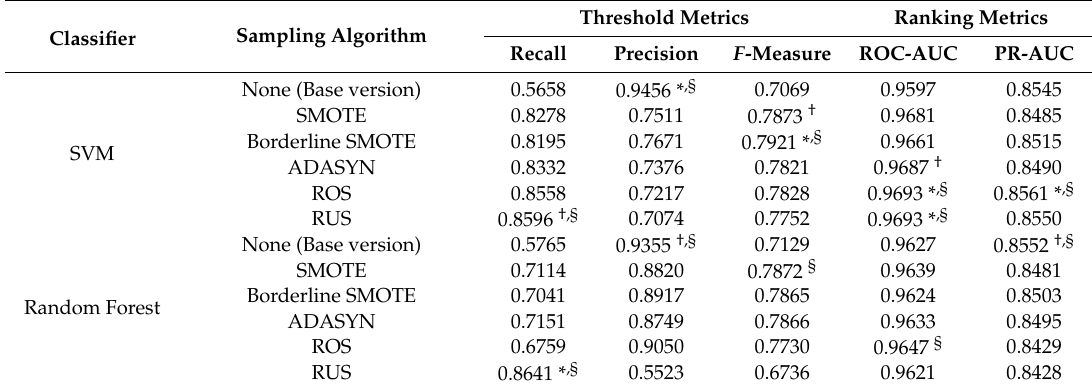
Table 3. Average of the metrics calculated through 10-fold cross-validation for both classifiers with